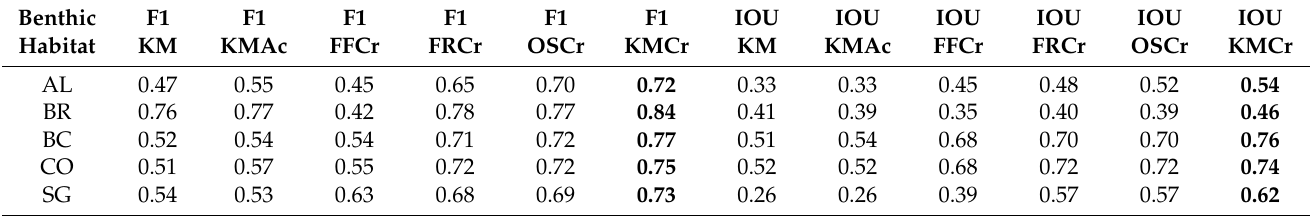
Table 2. The average F1-Score and IOU results of the proposed algorithms on the tested low illumi- nated and high contrast benthic habitat